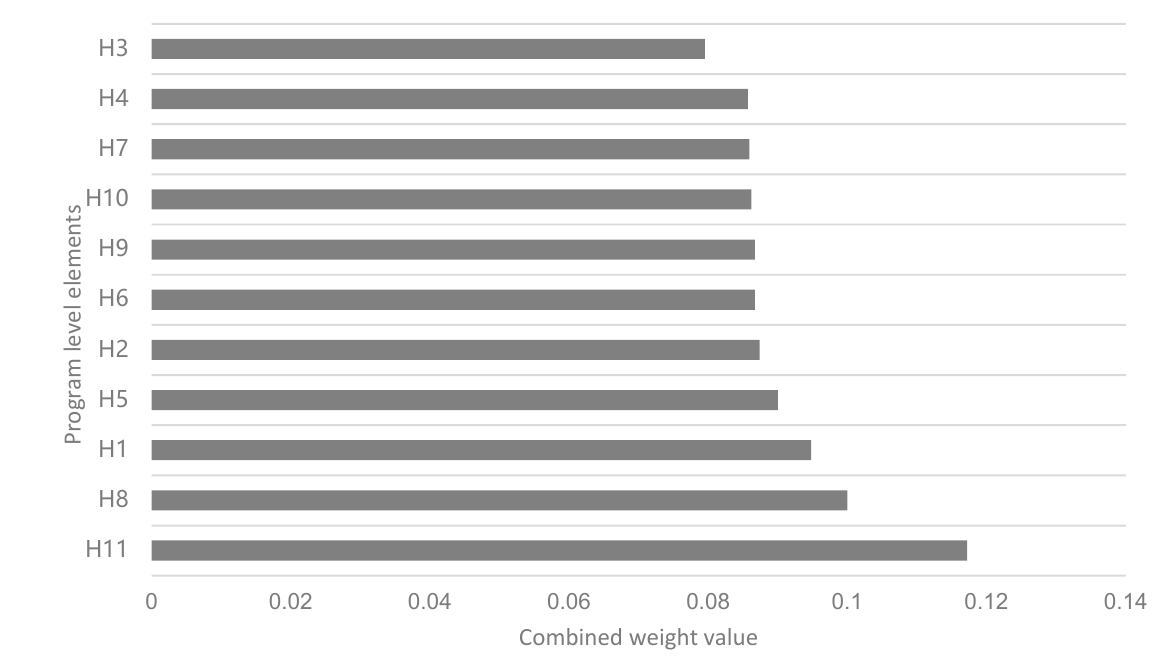
Figure 2. Statistical comprehensive weight values of criterion layer.